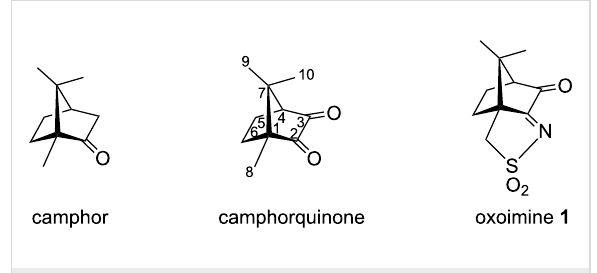
Figure 1: Camphor and some camphor